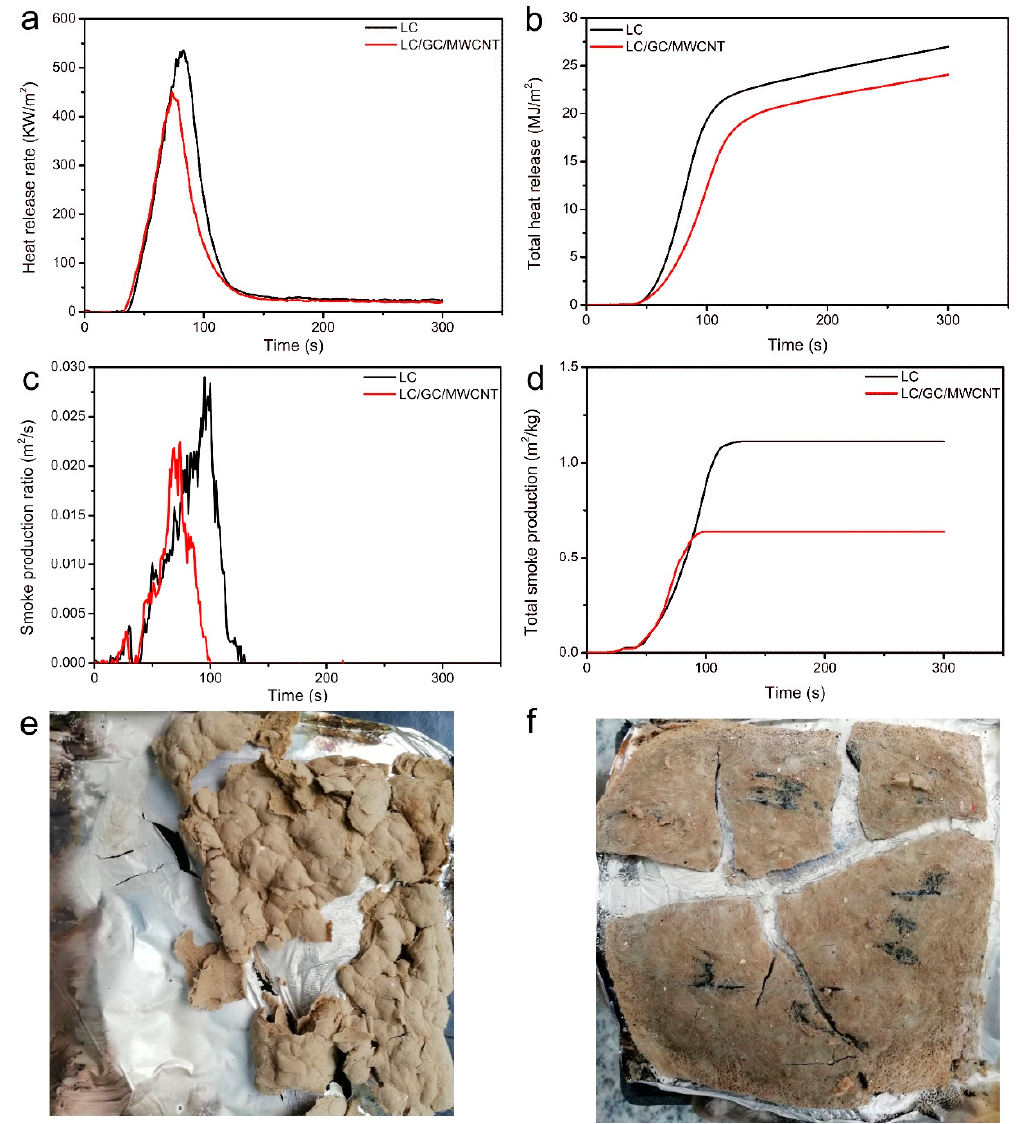
Figure 9. Cone calorimetry curves of LC composite and LC/GC/MWCNT composite: ( a ) heat release rate; ( b ) total heat release; ( c ) smoke production ratio; ( d ) total smoke production; ( e ) residues of LC composite; ( f ) residues of LC/GC/MWCNT composite.